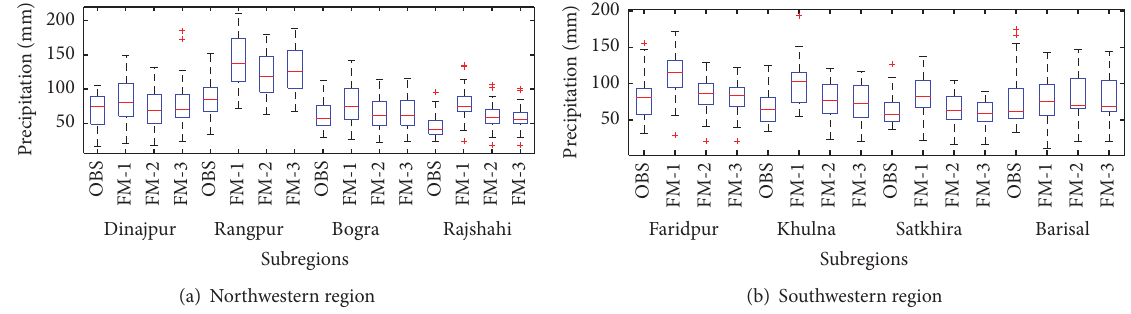
Figure 4: The temporal variations in average precipitation during the paddy growing season under observed and future climate change conditions in western Bangladesh. (a) The changes of precipitation in the northwestern region; (b) the changes of precipitation in the southwestern region. FM-1, FM-2, and FM-3 indicate three GCMs, namely, CGCM3.1, FGOALS-G1.0, and HadGEM1 models,